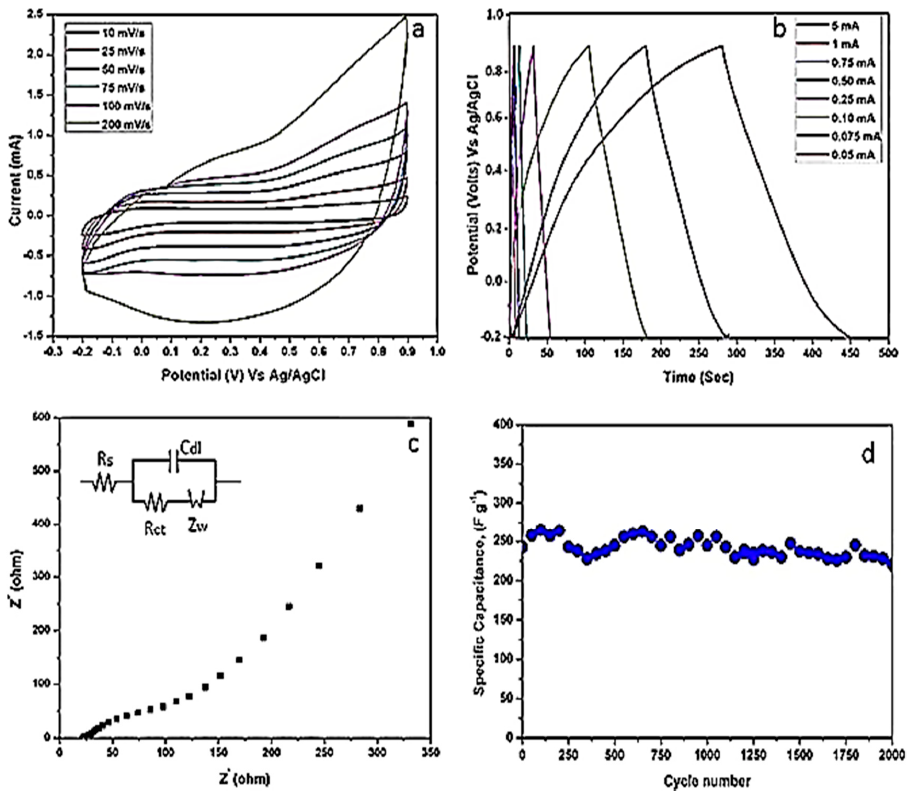
Figure 5. Electrochemical studies for g-CN loaded MnS: ( a ) CV plots, ( b ) galvanostatic charge and discharge plots, ( c ) Nyquist plot, and ( d ) plots for specific capacitance vs. cycle number [14].